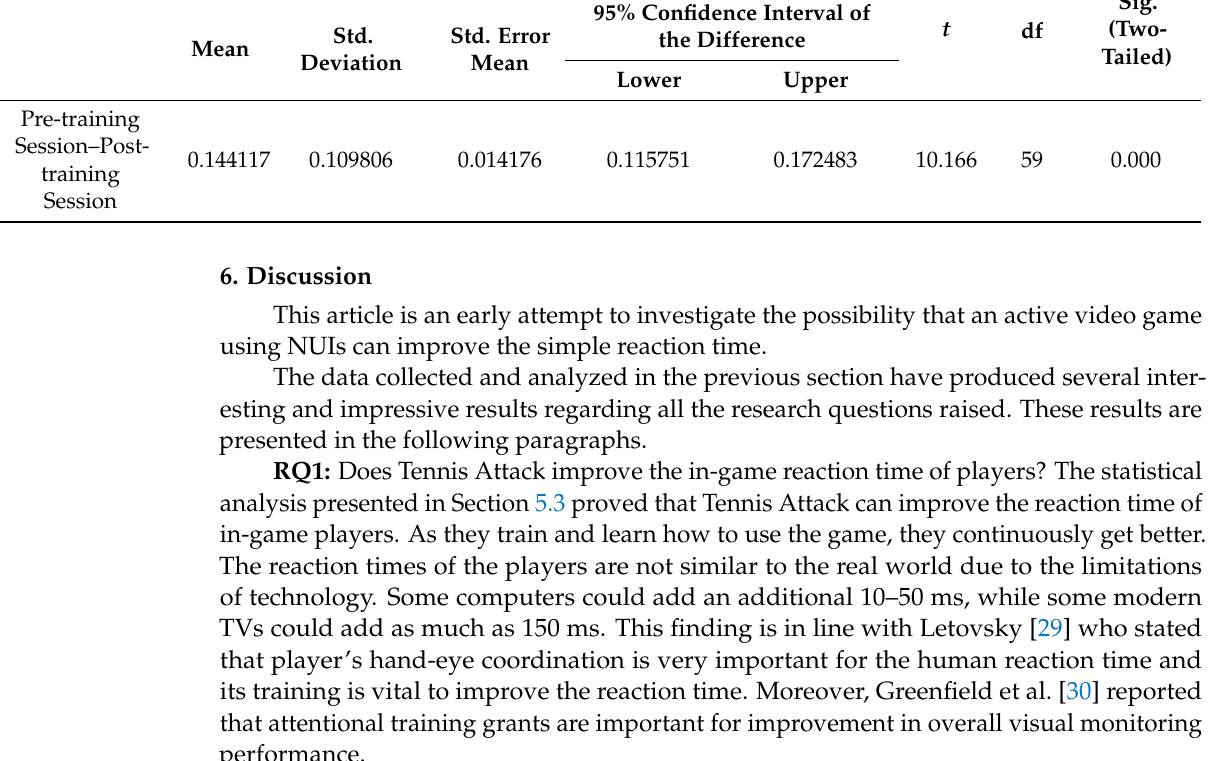
Table 7. Evaluation of statistical significance for improvement in the in-game reaction time. Paired Differences Std. Tailed)Mean